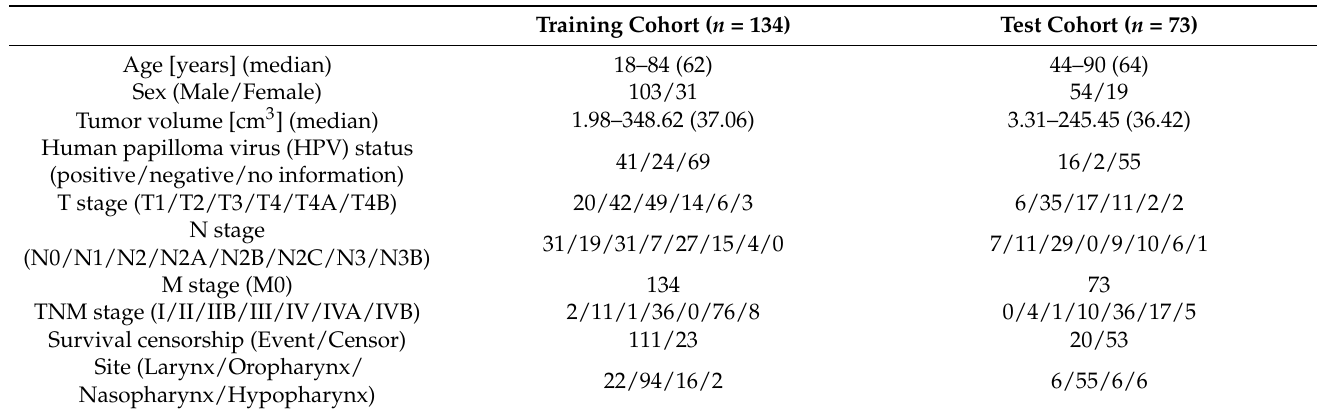
Table 1. Clinical variables of the patients in this